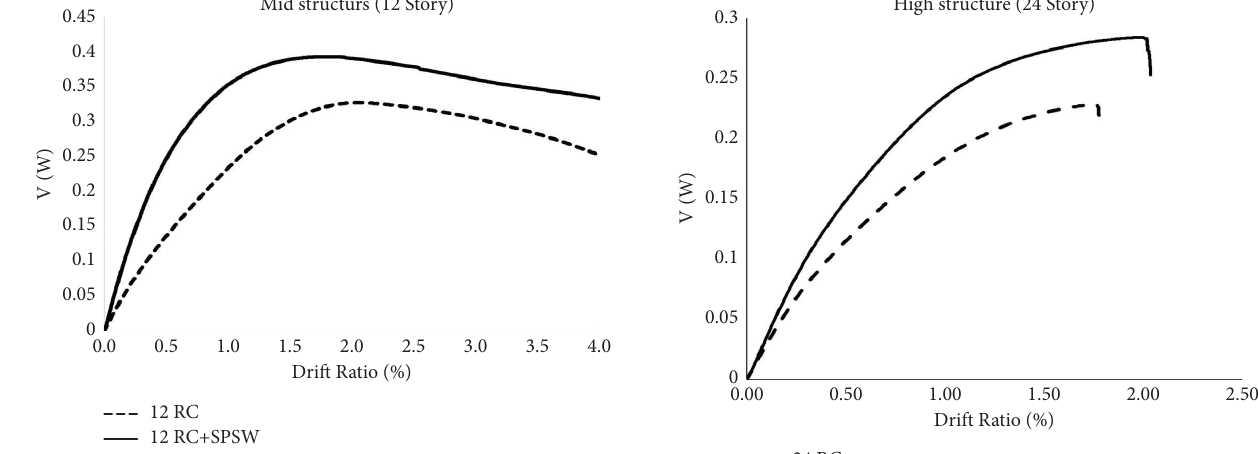
Figure 6: Result of nonlinear static analysis of mid-rise